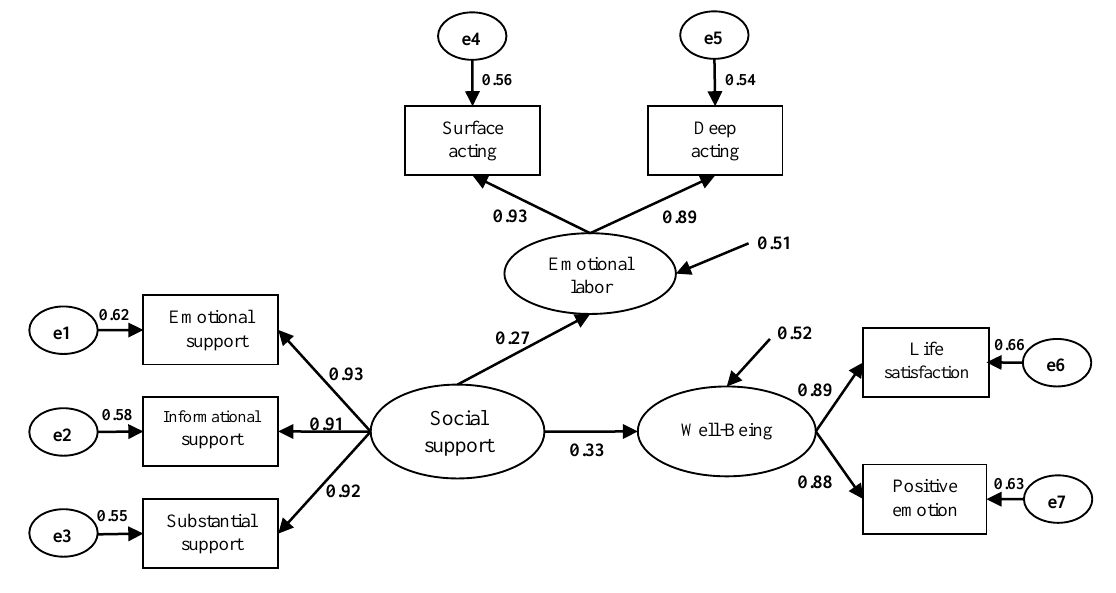
ff ect of emotional labor (step 1). Figure 2. Mediating effect of emotional labor (step 1). Figure 2. Mediating e